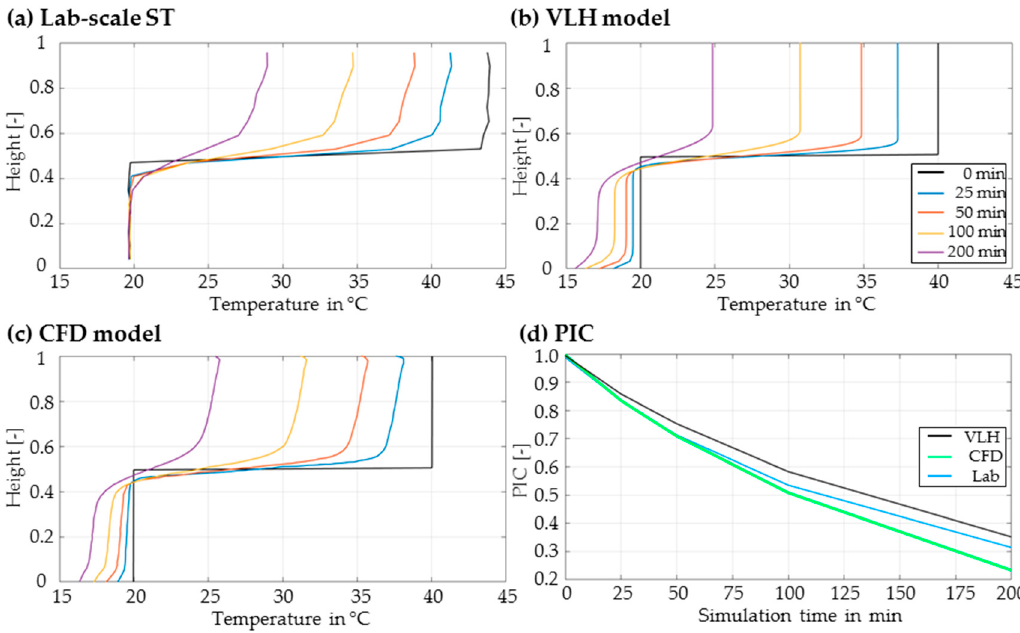
Figure 10. Influence of turbulent flows on stratification of the ( a ) lab, ( b ) VLH model and ( c ) CFD model during Charging , compared based on the ( d ) PIC value.